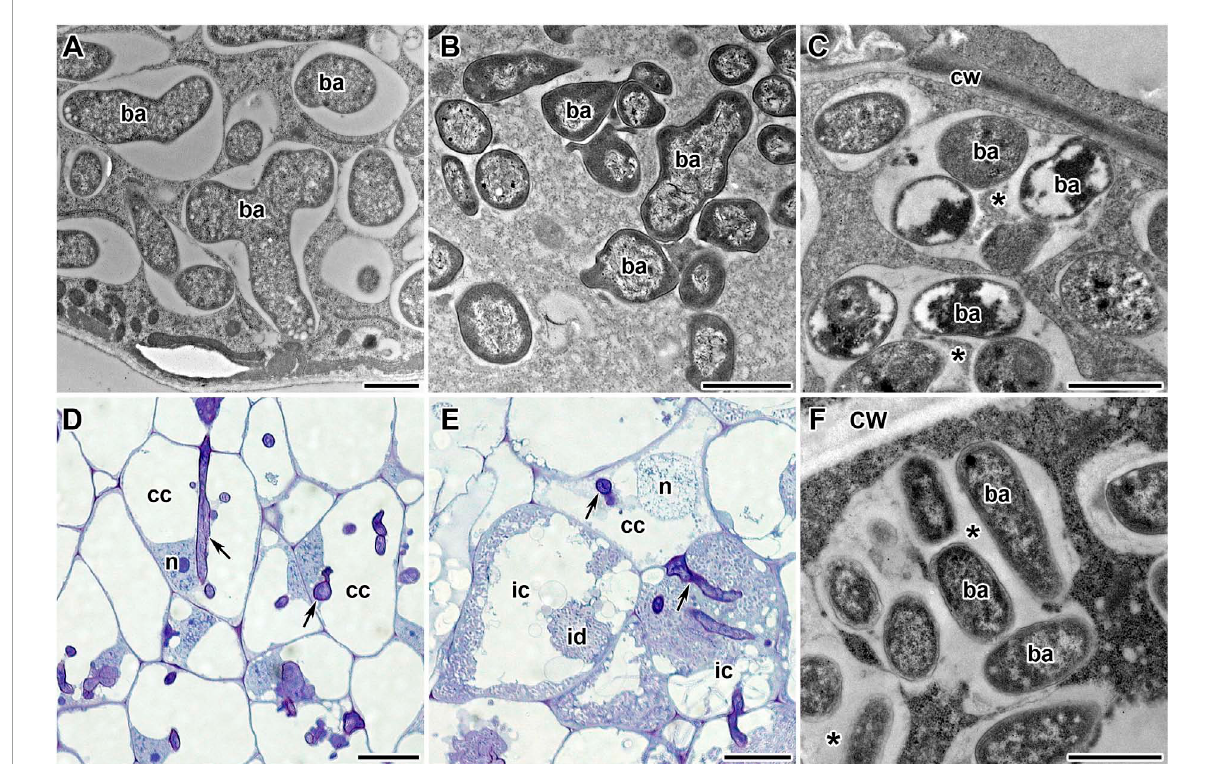
FIGURE8 Phenotypes of pea ( Pisum sativum L.) nodules. (A) Wild-type bacteroids. (B,C) Bacteroids of mutant SGEFix − -1 ( sym40-1 ): (B) abnormal bacteroids; (C) multibacteroid symbiosomes. (D–F) Phenotype of nodules of mutant SGEFix − -2 ( sym33-3 ): (D) nodule with “locked” infection threads and no release of bacteria; (E) nodule with occasionally released bacteria; (F) multibacteroid symbiosomes in the nodule with released bacteria. ic, infected cell; cc, colonized cell; id, infection droplet; n, nucleus; cw, cell wall; ba, bacteroid; *multibacteroid symbiosome. Arrows indicate infection threads. Scale bars = 1 µ m (A–C,F) and = 20 µ m (D,E)